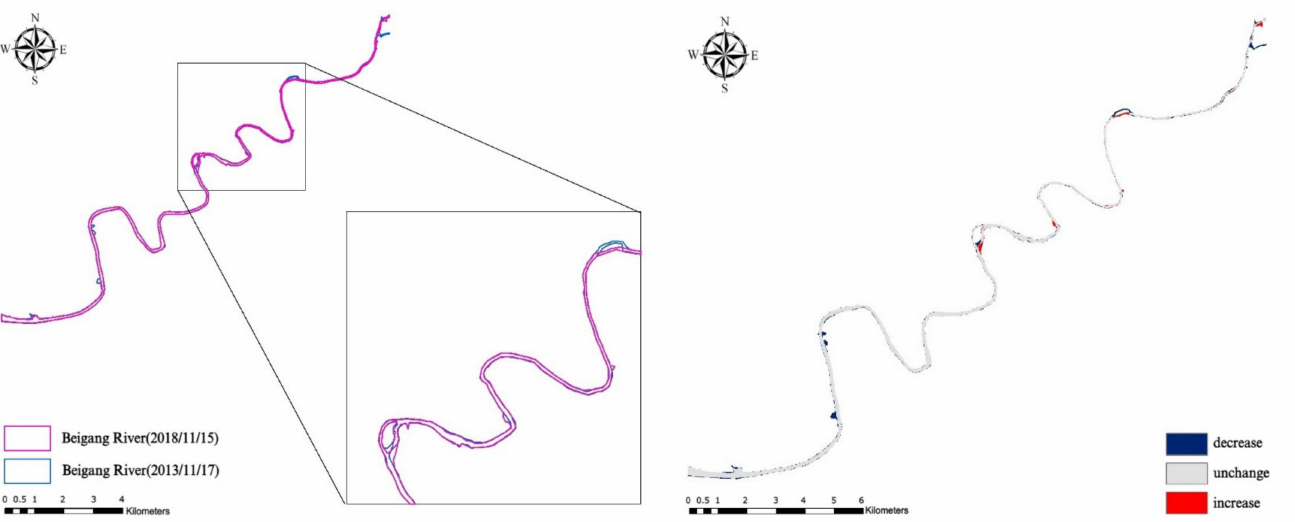
Figure 10. The Beigang River changes between two